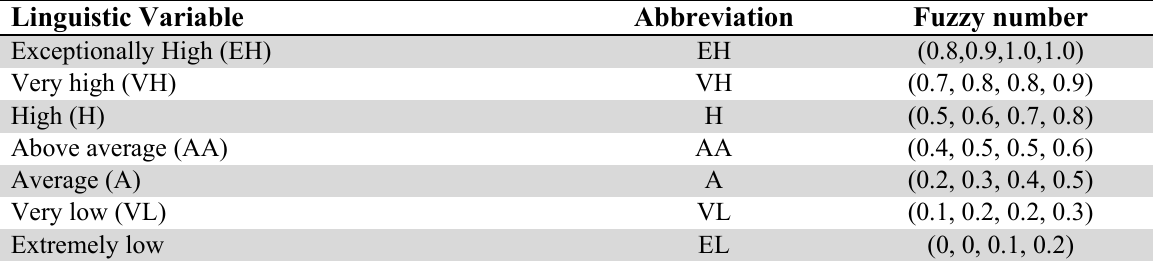
Linguistic Variable along with Corresponding Fuzzy Numbers Linguistic Variable Abbreviation Fuzzy number Exceptionally High